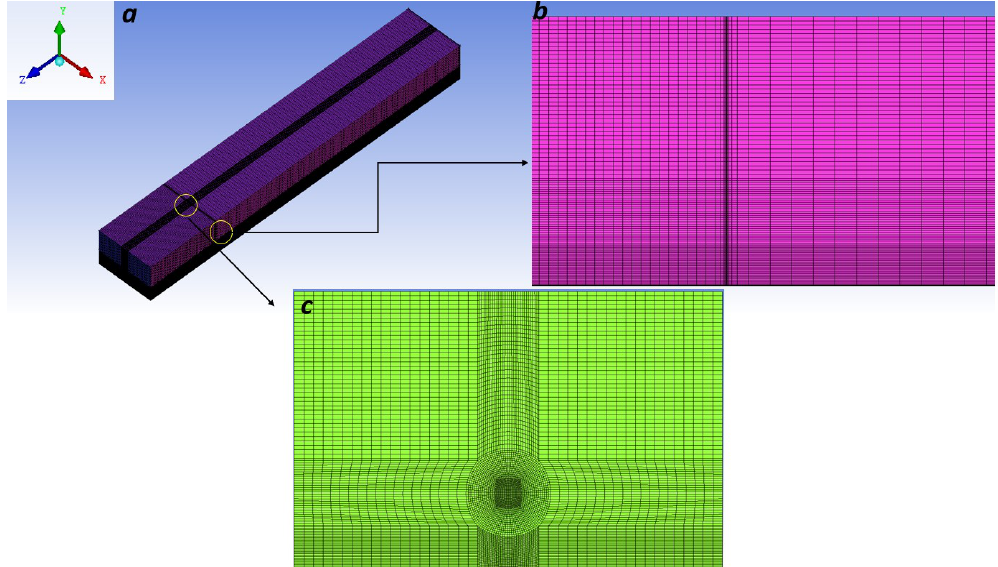
Figure 12. The domain mesh ( a ) isometric view ( b ) side view of the domain at the disk ( c )